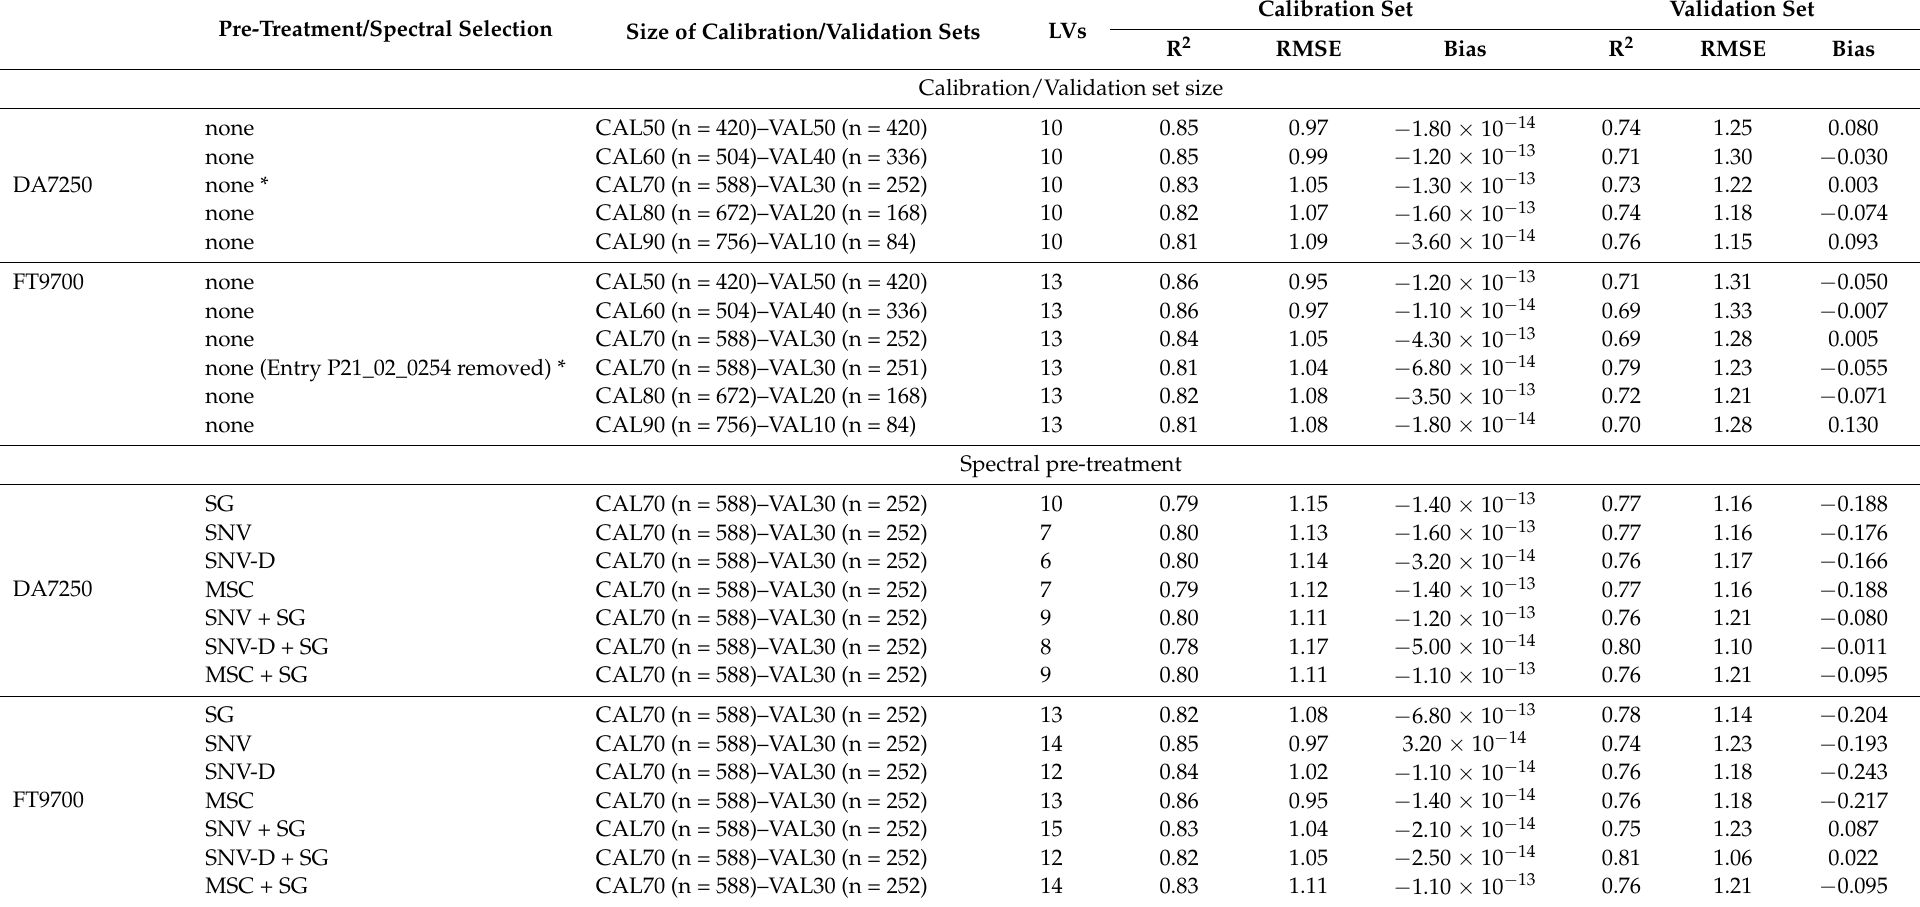
Table 4. Model evaluation parameters (R2, RMSE, and bias) for predictive models developed based on different considerations in the DA7250 and FT9700 NIRS